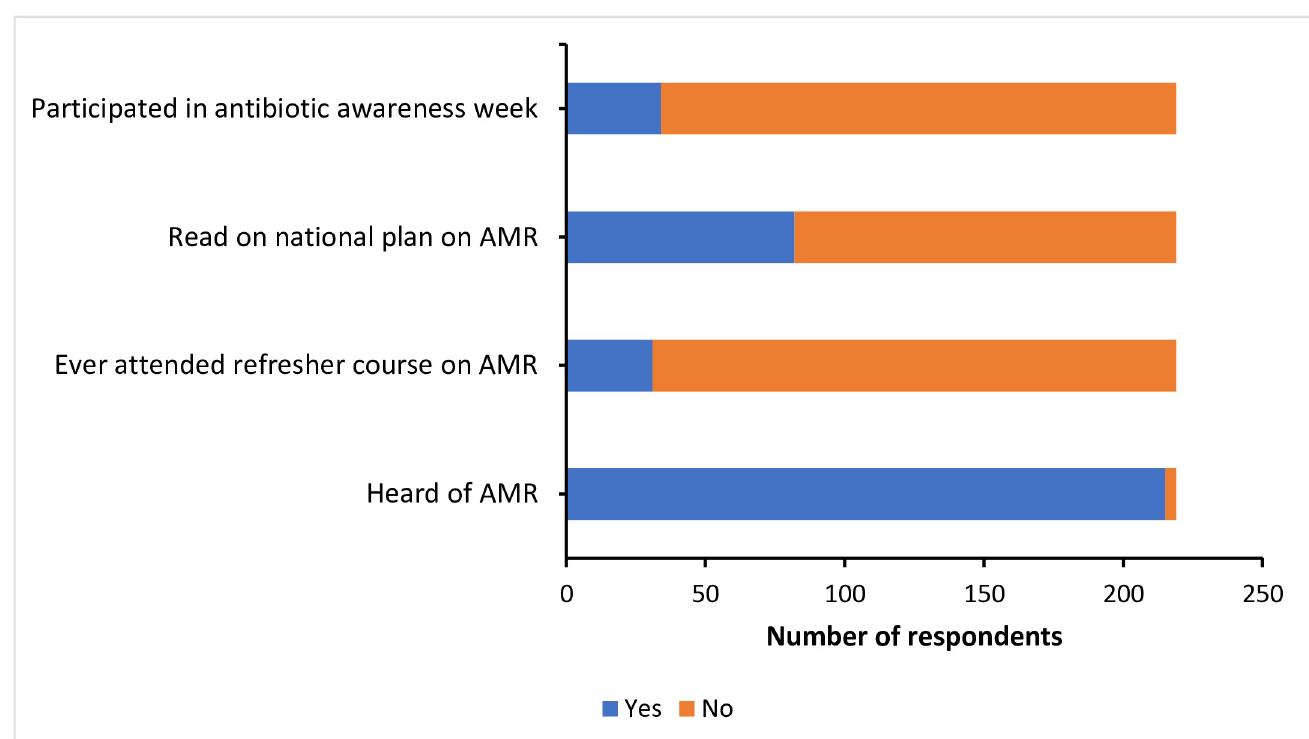
Fig 2. Level of knowledge and awareness on antibiotics and AMR among the 219 respondents (animal health workers in Bhutan).